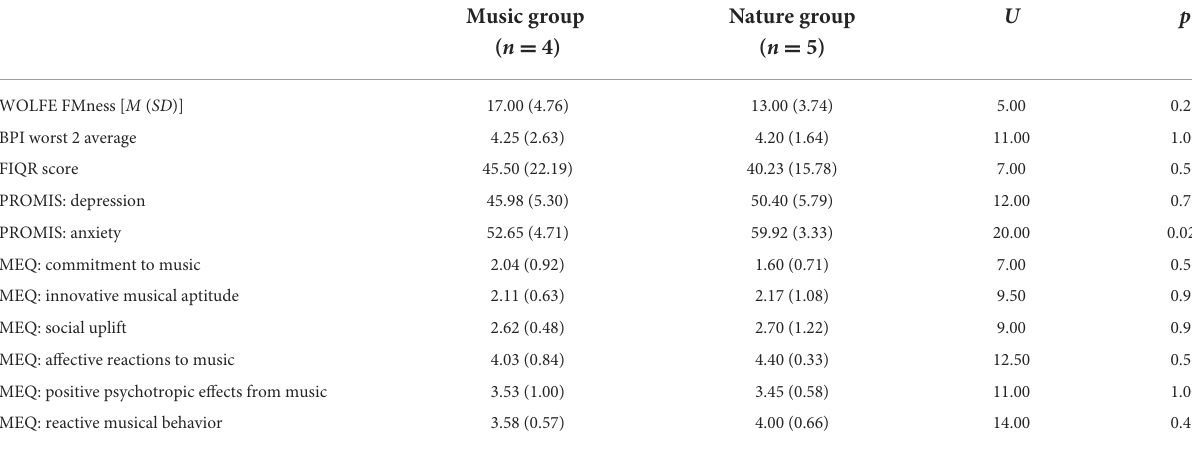
TABLE 2 Participant reported clinical and musical experience variables by audio group assignment (Music,